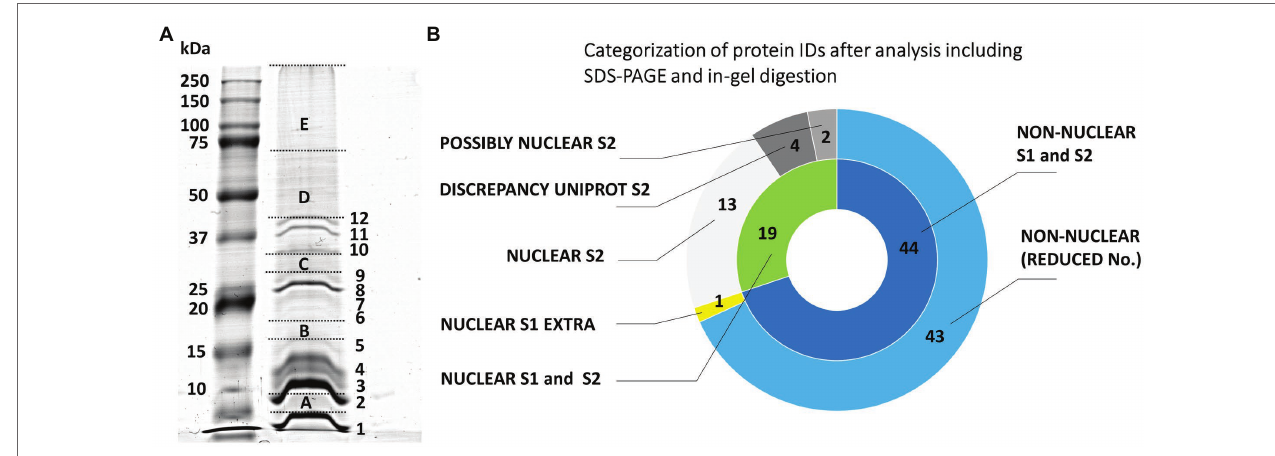
FIGURE 1 | Evaluation of the origin of proteins from mitotic chromosomes identified by GeLC-ESI-Q-TOF MS/MS. (A) SDS-PAGE of extracted barley chromosomal proteins (Coomassie Brilliant Blue staining). The separation was achieved in a 10% T/3.3% C resolving polyacrylamide gel. Left lane, protein marker 10–250 kDa (Kaleidoscope Standards, Bio-Rad); right lane, chromosomal proteins. The excised gel fractions and bands are labeled by capital letters A-E and numbers 1–12, respectively; this labeling is used in Supplementary Table S1 for reference. (B) The nested pie chart shows information on the possible nuclear or non-nuclear localization of all identified proteins and their distribution into categories reflecting results of a two-round search approach (S1 and S2) utilizing predictors based on data from gene ontology prediction tools, UniProtKB database annotations and conserved domain searches (NCBI CDD database). The principle of S1 and S2 sorting is elucidated in Materials and Methods. The inner ring shows combined results of the two data search and evaluation procedures. The area labeled “NUCLEAR S1 and S2” refers to the consistently obtained attributes NUCLEAR, PREDICTED NUCLEAR/DISCREPANCY UNIPROT, and POSSIBLY NUCLEAR. The outer ring shows a protein distribution based on the procedure S2 plus an additional non-overlapping hit obtained using S1 (“NUCLEAR S1 EXTRA”). The label “NON-NUCLEAR (REDUCED No.)” refers to subtraction of the non-overlapping hit from the total number of non-nuclear